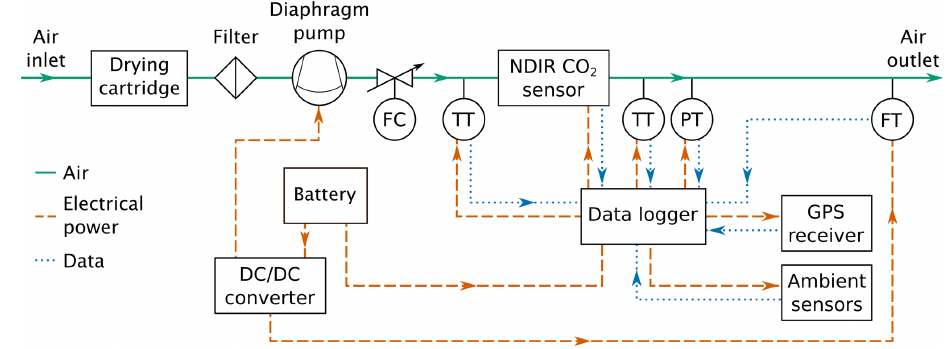
Figure 1. Flow of air, electrical power and data inside COCAP. FC – mass flow controller; TT – temperature transmitter (sensor); PT – pressure transmitter; FT – mass flow transmitter. The NDIR (nondispersive infrared) CO 2 sensor contains additional temperature sensors which are not included in this schematic